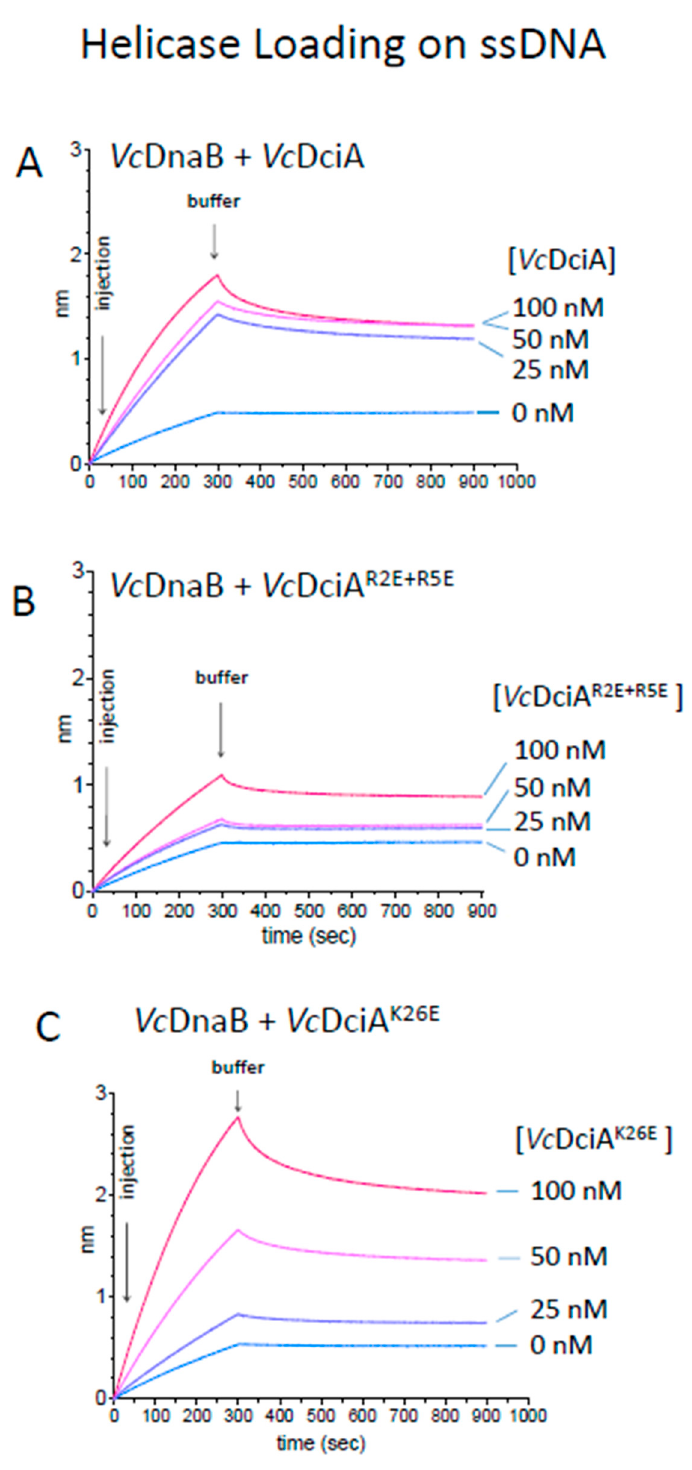
Figure 6. Vc DnaB loading by Vc DciA R2E+R5E and Vc DciA K26E compared to Vc DciA. Bio-layer interfer- ometry (BLI) analysis using biotinylated oligonucleotide oso23 (80 nt) immobilized onto the surface of a streptavidin (SA)-coated probe by its 3 (cid:48) extremity (see Section 3). Association was performed with the Vc DnaB helicase at a concentration of 100 nM during 300 s in a buffer solution containing ATP. Dissociation was assessed in the same buffer for 600 s. Increasing loader concentrations (0, 25, 50, and 100 nM in subunits, in cyan, blue, pink, and red, respectively) were analyzed. ( A ) Vc DnaB loading to ssDNA in the presence of Vc DciA. ( B ) Vc DnaB loading to ssDNA in the presence of Vc DciA R2E+R5E . ( C ) Vc DnaB loading to ssDNA in the presence of Vc DciA K26E